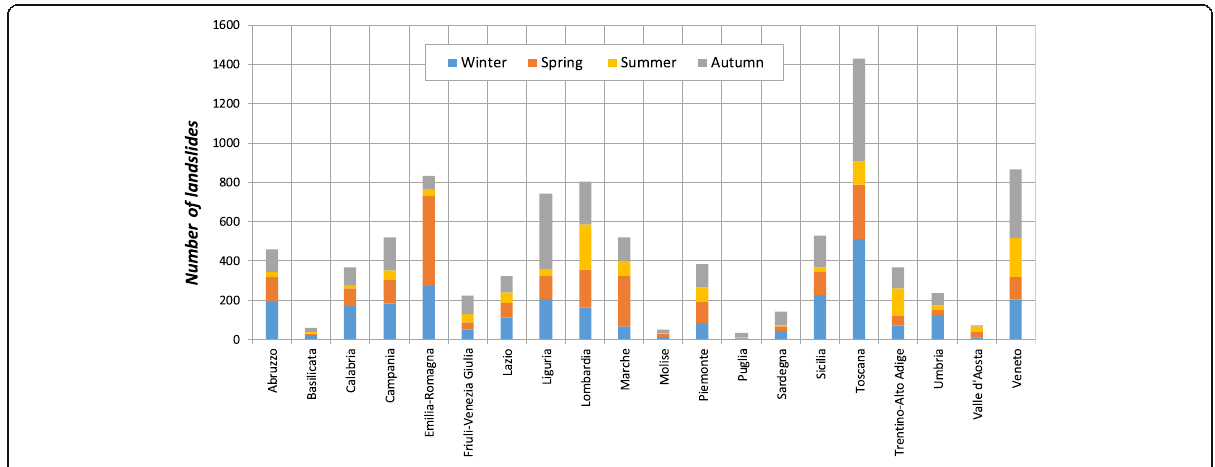
Fig. 5 Number of landslides inventoried in the 20 Italian regions, differentiated per